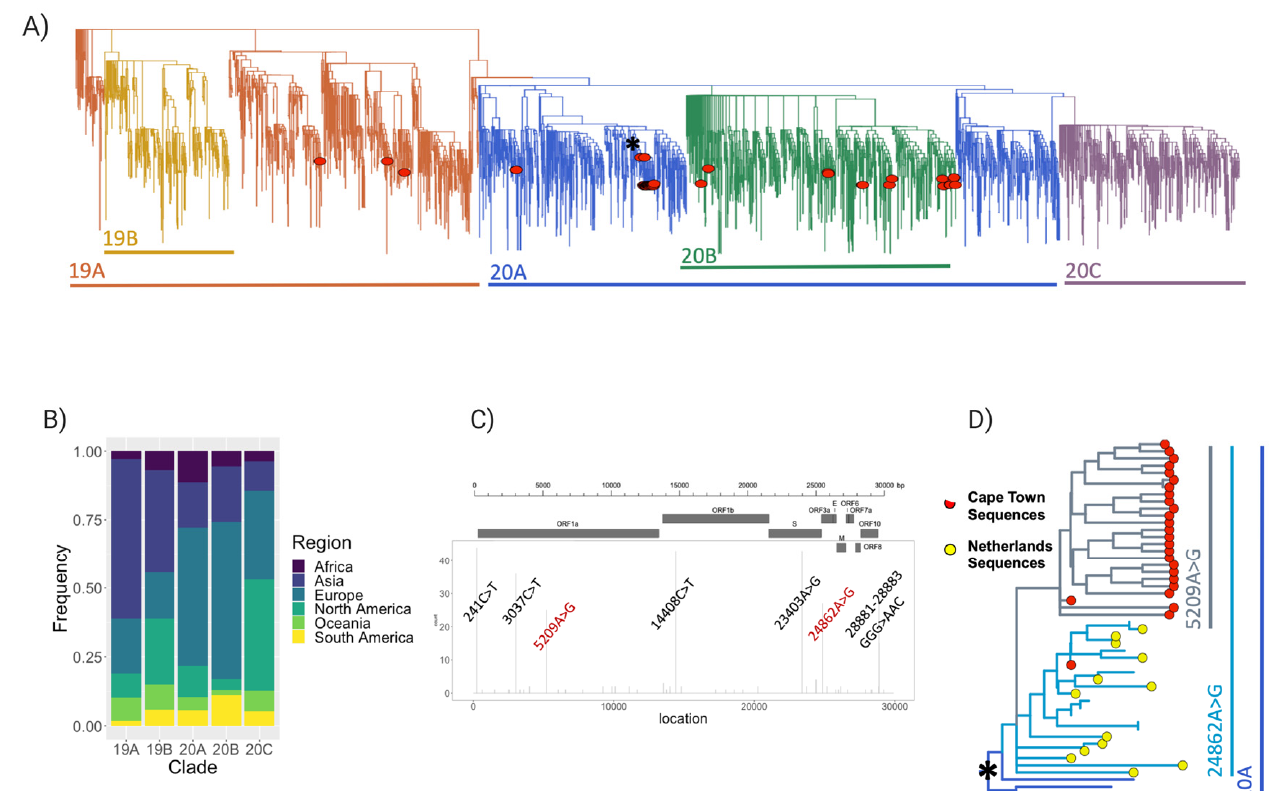
Figure 3. Phylogenetic and lineage analysis. ( A ) A time-scaled maximum-likelihood tree of 3620 sequences and 47 genotypes from Cape Town, Western Cape, South Africa. Major lineages of SARS-CoV-2 are labelled. ( B ) Stacked bar plot showing the lineage breakdown of the dataset by region, indicating the over-representation of lineage 20A (where most of the Cape Town sequences lie) with origins from Europe. ( C ) Genomic location and frequency of variants among the 47 genomes generated in this study mapped onto the genomic structure of SARS-CoV2, with common variants labelled. Variants labelled in red are observed either uniquely or at higher frequencies in our sequences compared to their global distribution. ( D ) Monophyletic cluster within the Cape Town sequences, showing closest divergence from isolates originating in the Netherlands, and the emergence of a Cape Town specific mutation within that cluster. This is a zoom-in of the tree in (A) at the position indicated by the asterisk